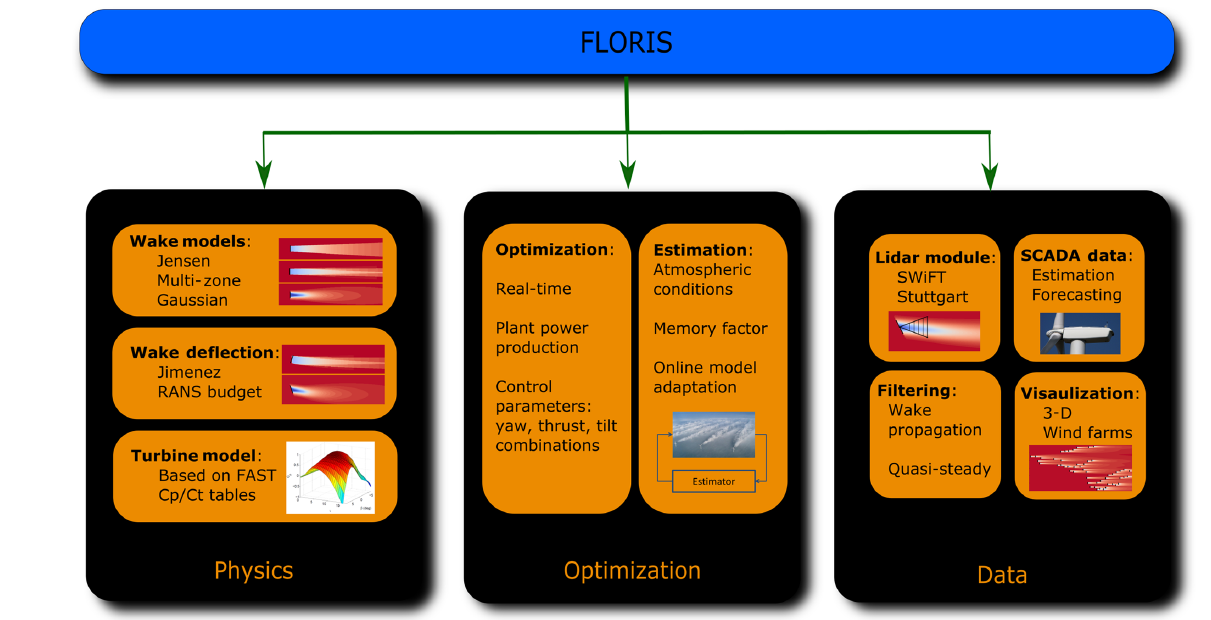
Figure 1. The FLORIS tool set is comprised of three main sections: (1) physics, (2) optimization, and (3)